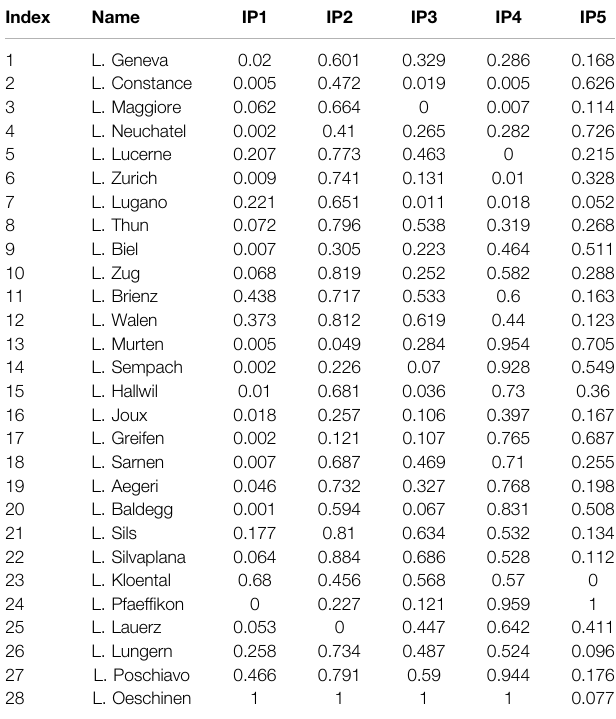
TABLE 3 | Normalized input parameters for each